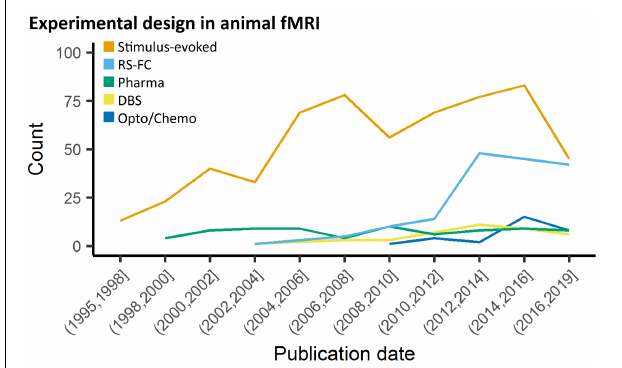
FIGURE 2 | Study design in animal fMRI over time. Stimulus-evoked fMRI (events or blocks related) remain the major component within animal literature. From 2006 and 2010, resting-state fMRI and opto-/chemogenetic fMRI, respectively, have represented an increasing proportion of the animal fMRI